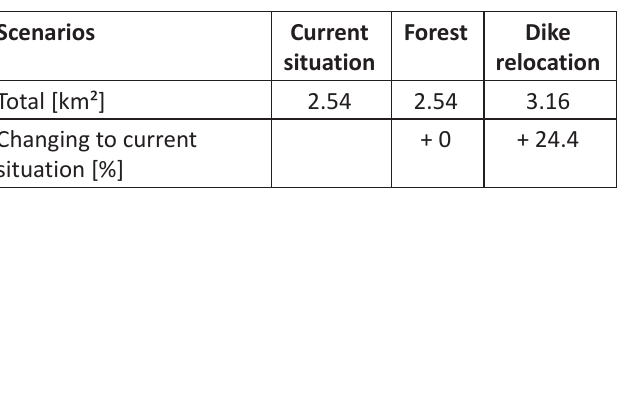
Table 2. Results of the FHR-indicator for the three